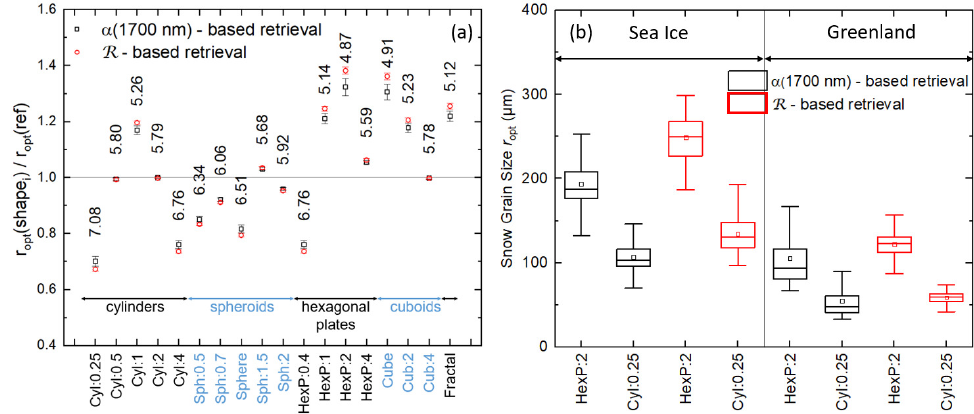
Figure 10. ( a ) Ratio of retrieved snow grain size for various particle shapes and the reference mixed shape based on LUTs from TARTES simulations for SZA = 80°. The shape-dependent form factors A are given within the plot next to the r opt -averaged values. The vertical bars indicate the standard deviation of the r opt -averaging. The studied shapes: cylinders (Cyl), spheroids (Sph), hexagonal plates (HexP), cuboids (Cub), and fractals are selected according to the TARTES internal shape list from Libois et al. [43]. The number behind the shape abbreviation gives the aspect ratio of the particle. ( b ) Retrieved r opt from SMART measurements over sea ice and Greenland on 25 March 2018 assuming the two particle shapes hexagonal plates and